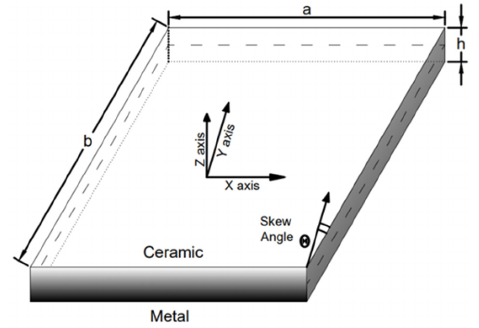
Figure 1. Geometry of skew functionally graded plate.